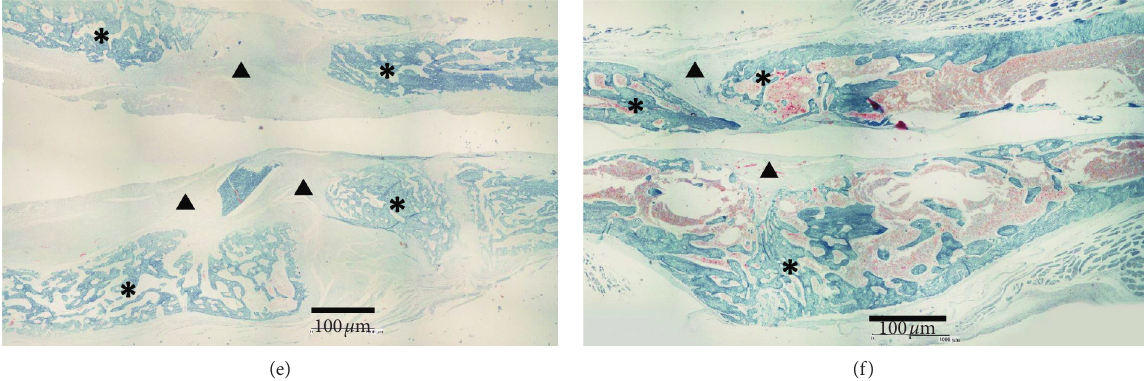
Figure 2: Histologic images of fracture bone tissue of rats on day 7, 35, and 60 after surgery. On day 7 after the surgery, the soft callus area (triangle) in the control group (a) was narrow than the MSC-CM group (b). On day 35 after the surgery, the soft callus area is still wider on the control group (c), while in the MSC-CM group (d), the hard callus area was dominant. On day 60 after the surgery, in the control group (e), the soft callus area still dominated the bone tissue, while the soft callus area was almost entirely replaced by the hard callus area (star) in the MSC-CM group